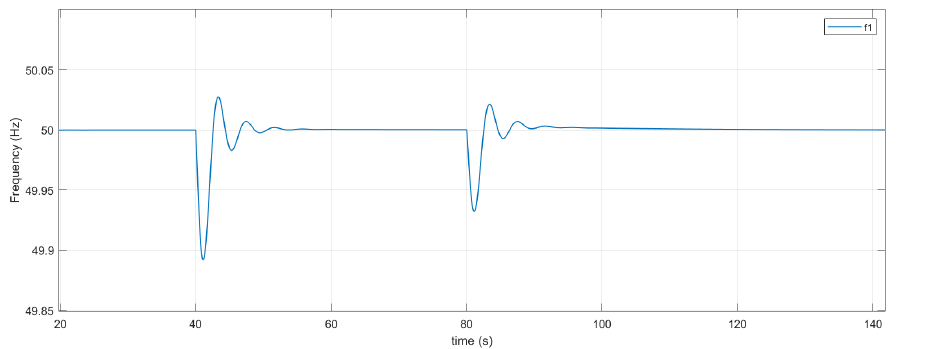
Figure 10. The Frequency of area 1.